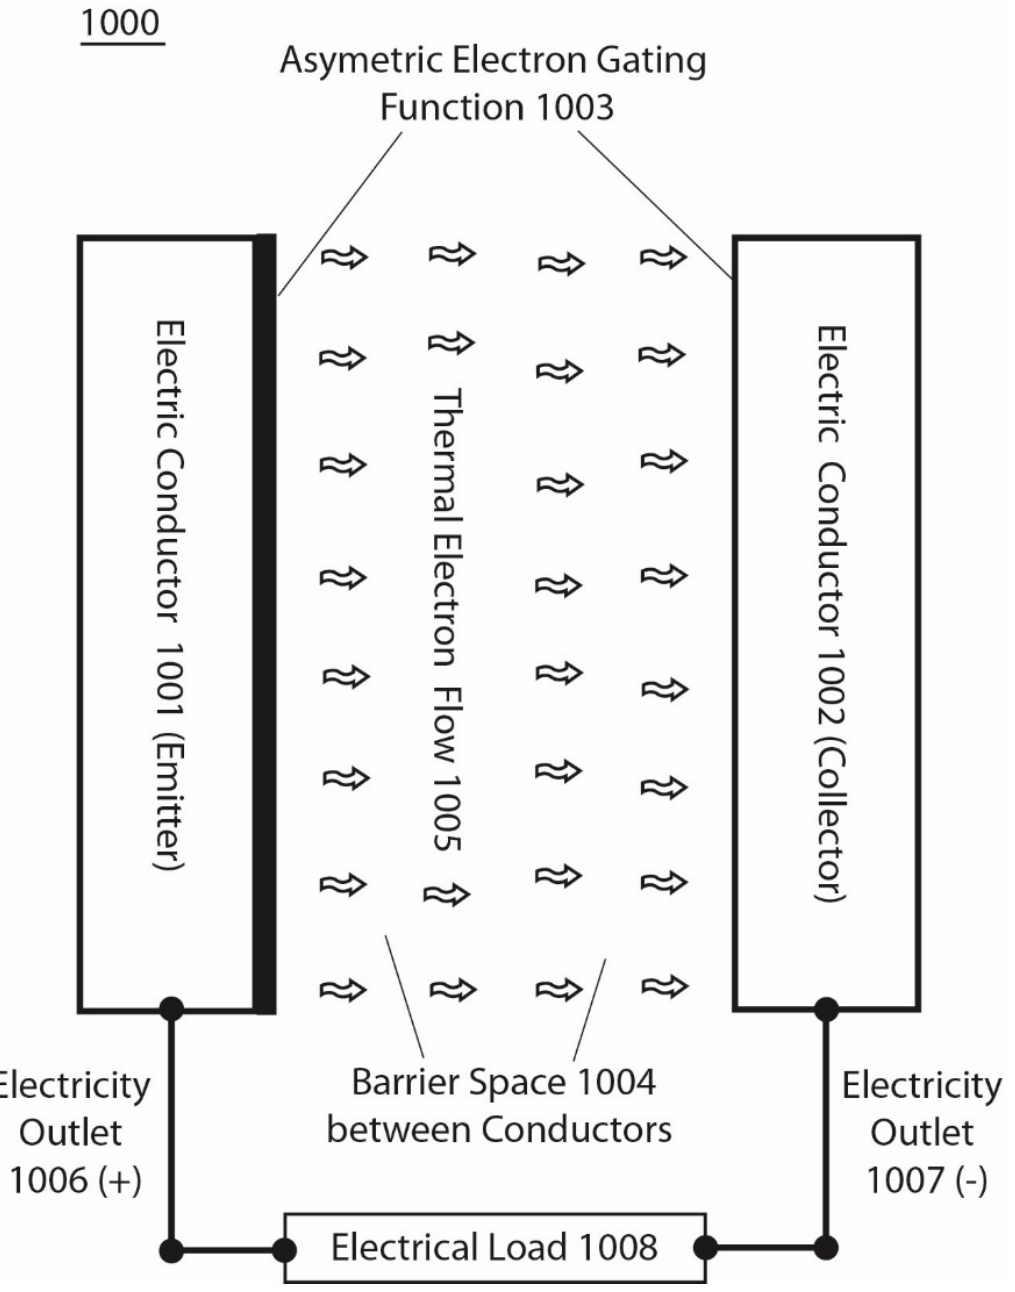
Figure 1. Presents an asymmetric electron-function-gated isothermal electricity power generator system 1000 comprising an asymmetric electron-gating function across an insulating membrane-like barrier space gap that separates two electrical conductors.